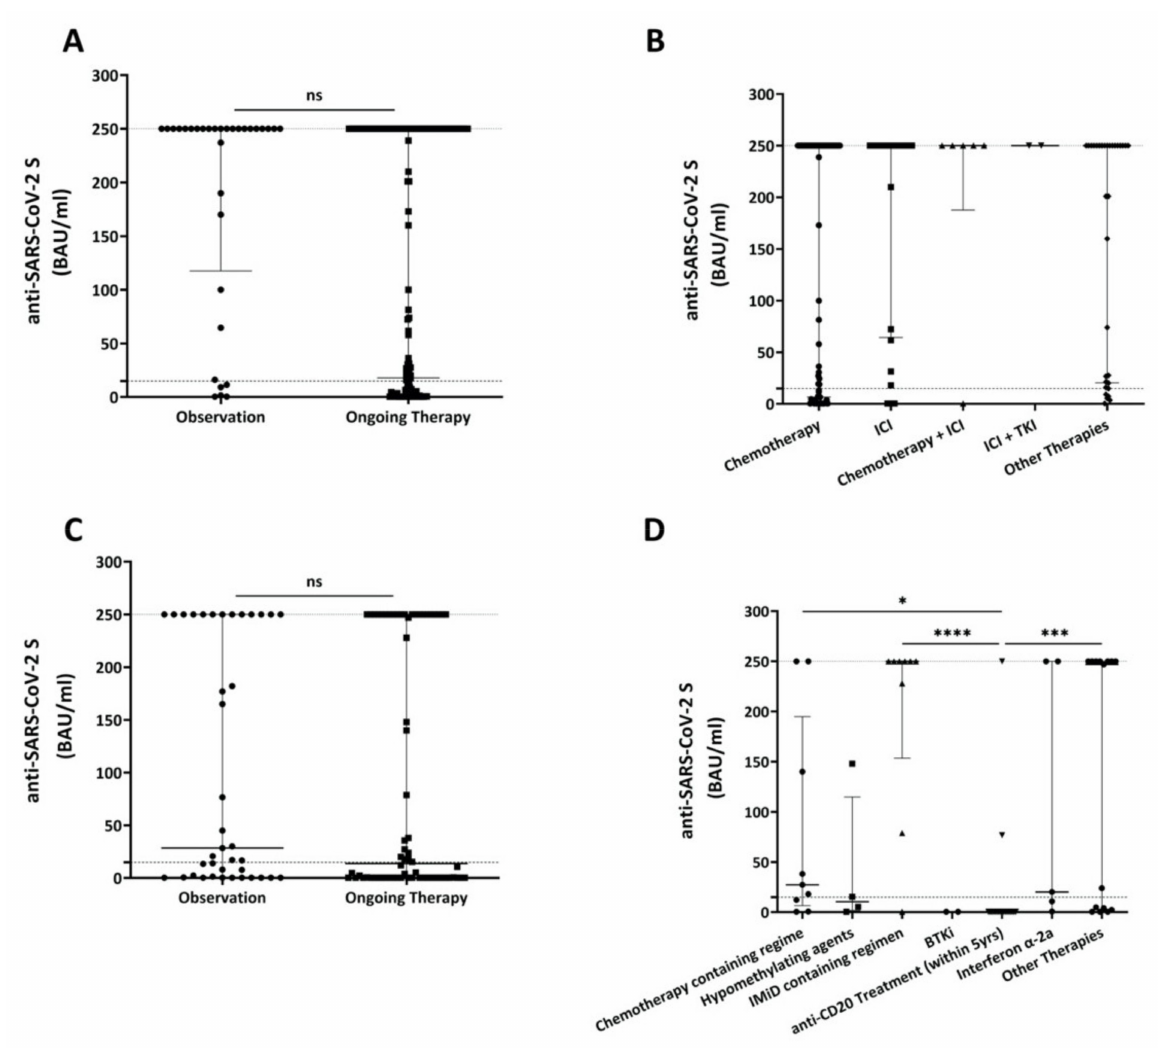
Figure 3. Comparison of antibody levels based on oncological treatment. ( A ) Comparison of antibody levels after COVID-19 vaccination in solid tumor patients that were observed only with patients receiving any type of oncologic therapy. ( B ) Comparison of different oncologic therapies with respect to antibody formation upon COVID-19 vaccination. ( C ) Comparison of antibody levels after COVID-19 vaccination in hematologic patients that were observed only with patients receiving any type of hematologic therapy. ( D ) Comparison of different hematologic therapies with respect to antibody formation upon COVID-19 vaccination. Here, only selected therapies were analyzed. Threshold (lower dotted line) indicates ≥ 15 BAU/mL; the upper dotted line shows the upper limit of the assay (250.01). Displayed are median values and 95% CI of BAU/mL values (upper and lower ends of error bars). ns: not significant, * p < 0.05, *** p < 0.001, **** p < 0.0001. BAU: Binding Antibody Units; ICI: Immune Checkpoint Inhibitor; TKI:Tyrosine Kinase Inhibitor; IMID: Immunomodulatory Imide Drug; BTKi: Bruton’s Tyrosine Kinase